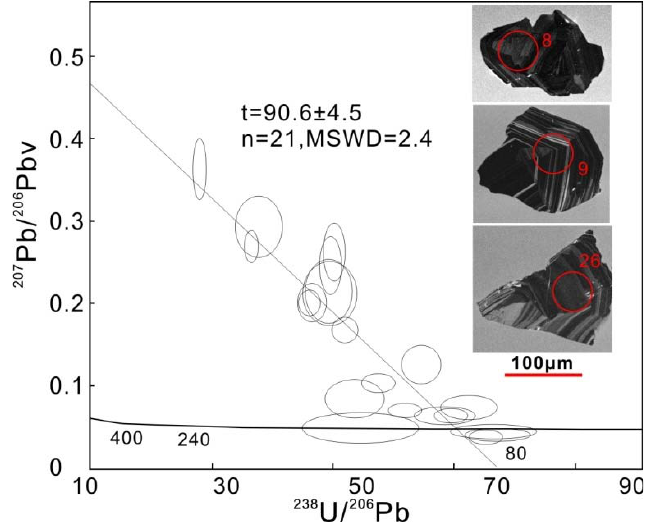
Figure 4. Tera – Wasserburg U–Pb diagram for cassiterites from the Beixiang deposit. Insets show Figure 4. Tera—Wasserburg U—Pb diagram for cassiterites from the Beixiang deposit. Insets show cathodoluminescence images of representative cassiterite samples. cathodoluminescence images of representative cassiterite samples. Table 1. LA ‐ ICP ‐ MS U ‐ Pb dating results of cassiterite from the Beixiang deposit. Table 1. LA-ICP-MS U-Pb dating results of cassiterite from the Beixiang